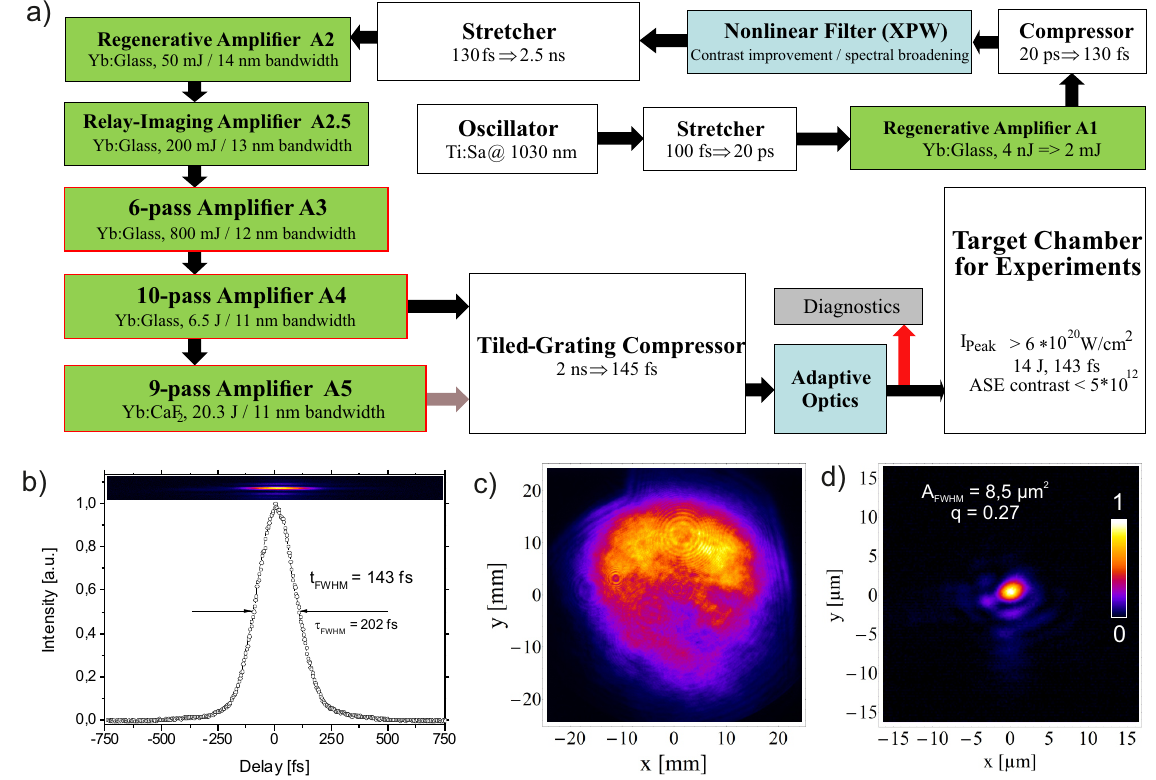
Figure 1. Setup and measurements of POLARIS. ( a ) Schematic setup. The